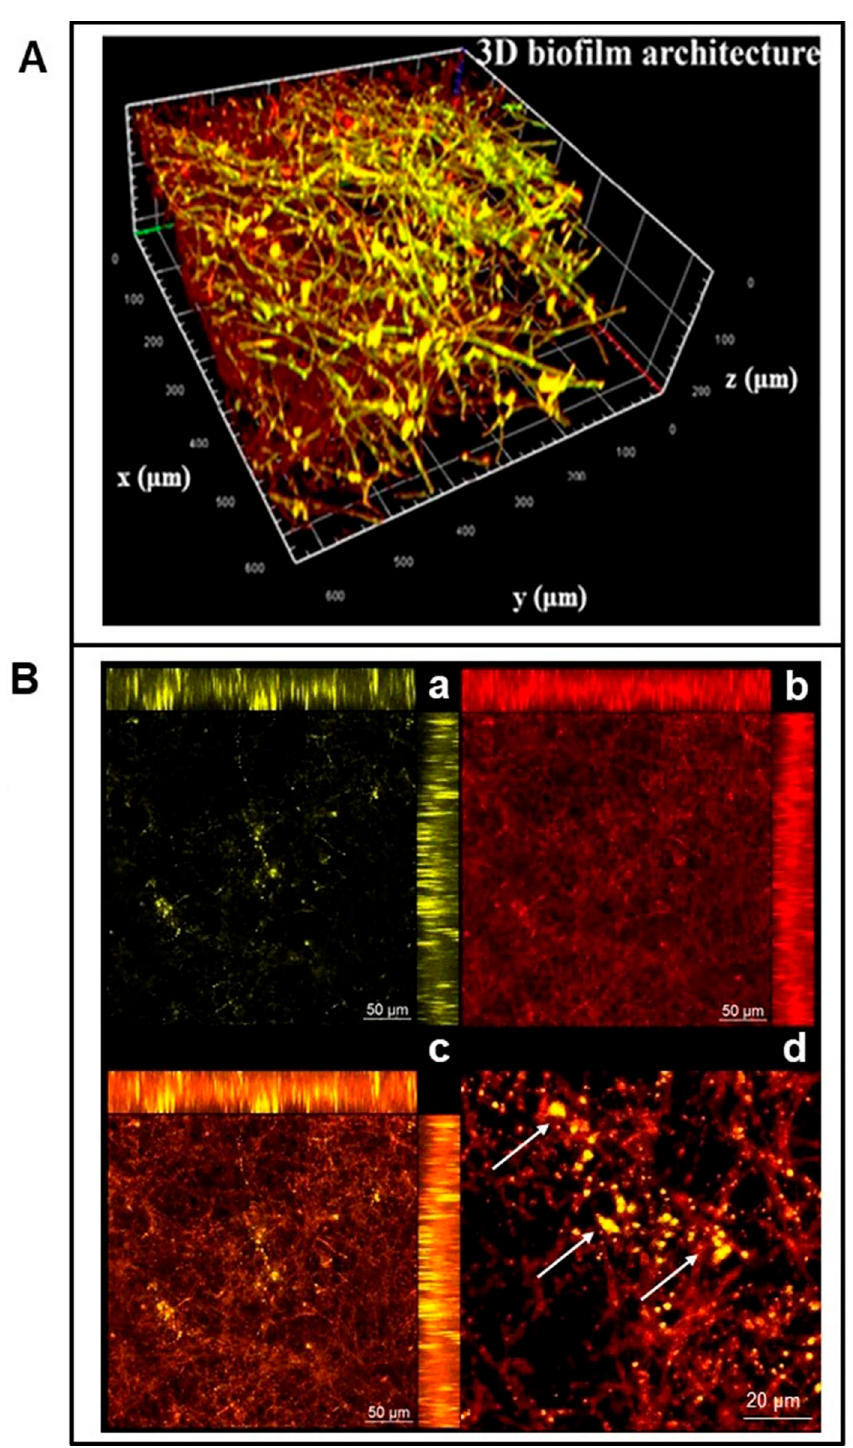
Figure 1- Candida albicans biofilm characterization. (Upper panel) A. CLSM of a 3D architecture of the 36-h C. albicans biofilm stained with SYTO9 and concanavalin Alexa-Fluor 594 nm. The biofilm presented a green-yellow-red fluorescence and thickness of 121.88 µm. (Down panel) B. CLSM images of the 36-h C. albicans biofilm with Nile Red staining. (B.a) Neutral lipids stained in yellow. (B.b) Polar lipids stained in red. (B.c) Lipid storage (Gold-yellow intracellular spots – white arrow). (B.d). Detailed lipid storage.